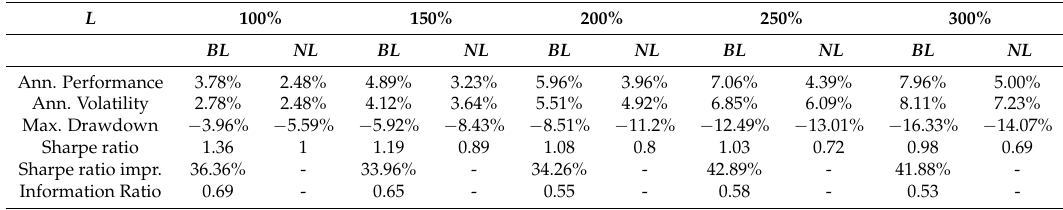
Table 5. Statistics for BL and NL strategies with different levels of maximum leverage L . The Sharpe ratio improvement is calculated as the relative difference between BL and NL Sharpe ratios for the same level of maximum